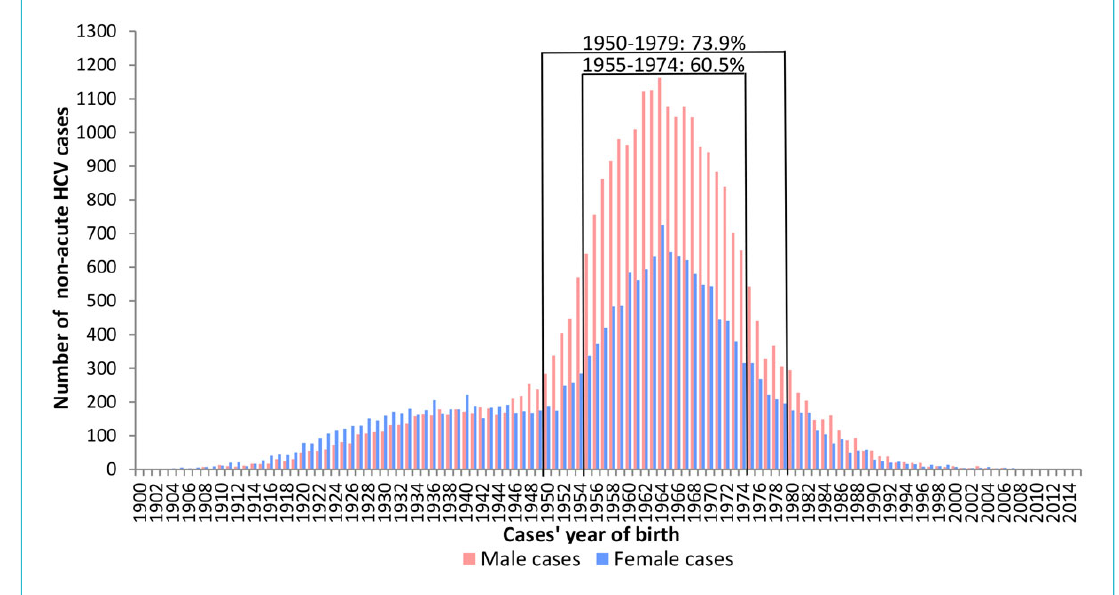
Figure 6: Number of reported non-acute hepatitis C virus cases by gender and birth cohort, and percentage of total cases for 20 or